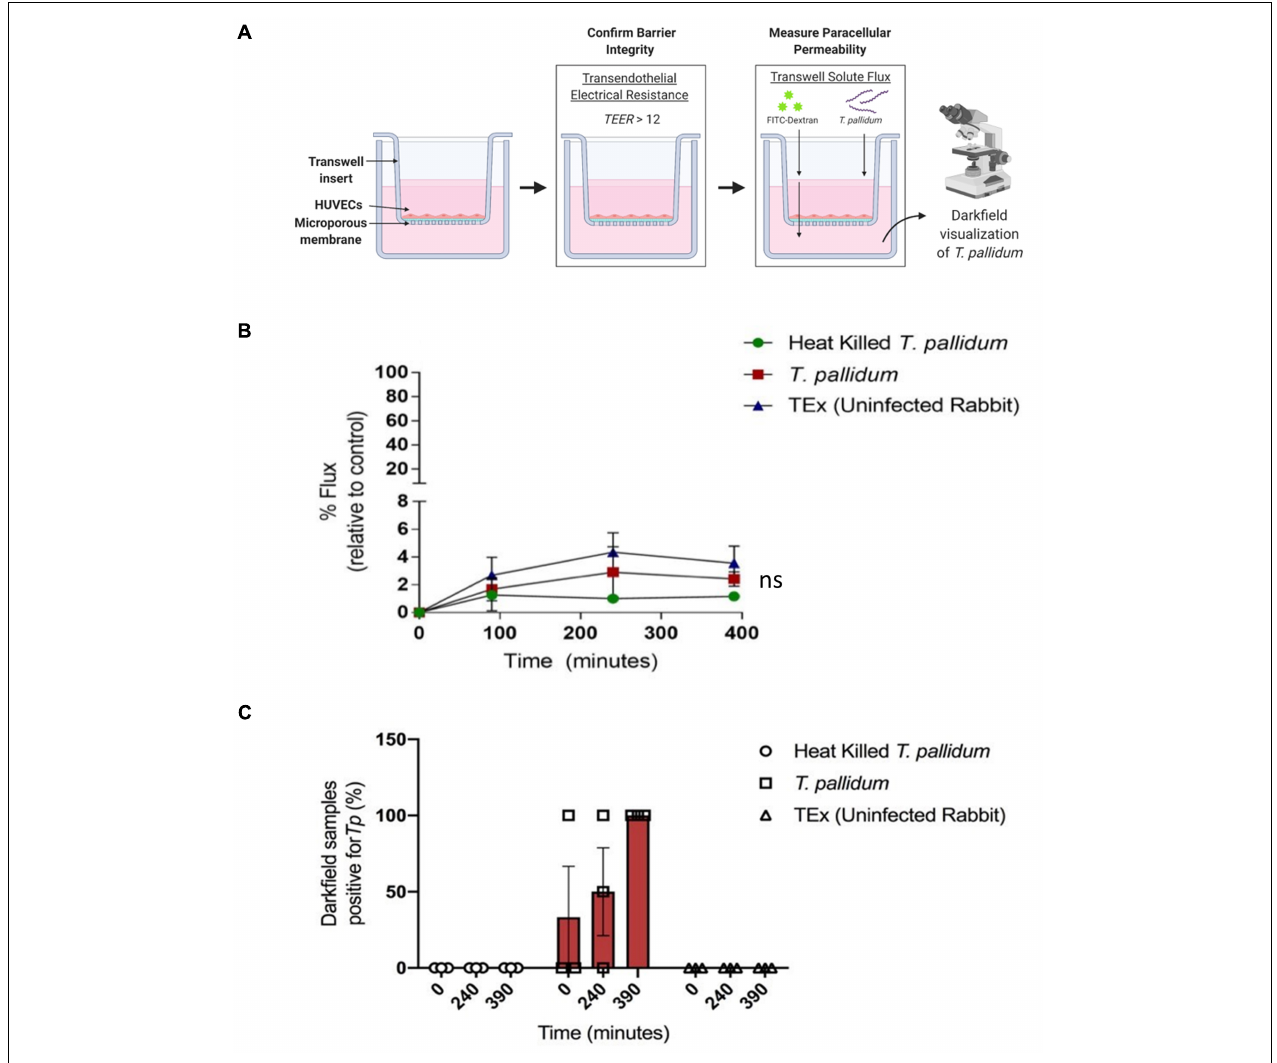
FIGURE 6 | Treponema pallidum traverses endothelial barriers without disrupting barrier integrity. (A) Schematic of transwell solute flux assay of endothelial monolayers exposed to T. pallidum . HUVECs were seeded onto an artificial basement membrane in transwell inserts and grown to confluence. Barrier integrity was confirmed using TEER, where monolayer resistance > 12 (cid:127) × cm 2 dictated an intact monolayer. Barrier permeability was assessed with a transwell solute flux assay, where endothelial permeability in the presence of T. pallidum was monitored with a FITC-dextran fluorescent tracer by sampling from the bottom compartment of the transwell for fluorescence measurements throughout the time course. Image created with BioRender. (B) Solute permeability of HUVEC monolayers was evaluated with the fluorescent tracer FITC-dextran in the presence of T. pallidum , heat-killed T. pallidum , or testicular extract from uninfected rabbits over 6.5 h. Results are normalized to transwells containing artificial basement membrane without endothelial cells (set as 100% flux of FITC-dextran) and presented as mean ± SEM from three independent experiments. Statistical significance was analyzed by two-way ANOVA comparing T. pallidum , heat-killed T. pallidum , and testicular extract from uninfected rabbits [“TEx (Uninfected Rabbit)”]; treatment factor ns p = 0.707; time factor p = 0.004. (C) Darkfield analysis of duplicate 10- µ l samples taken from the bottom chambers from endothelial cells treated with live T. pallidum , heat-killed T. pallidum , or TEx (Uninfected Rabbit) from three separate experiments at each timepoint. Data points represent the percentage of darkfield positive samples from each independent experiment. Slides were scanned for 10 different fields of view and the presence of ≥ 1 T. pallidum cell was recorded as a